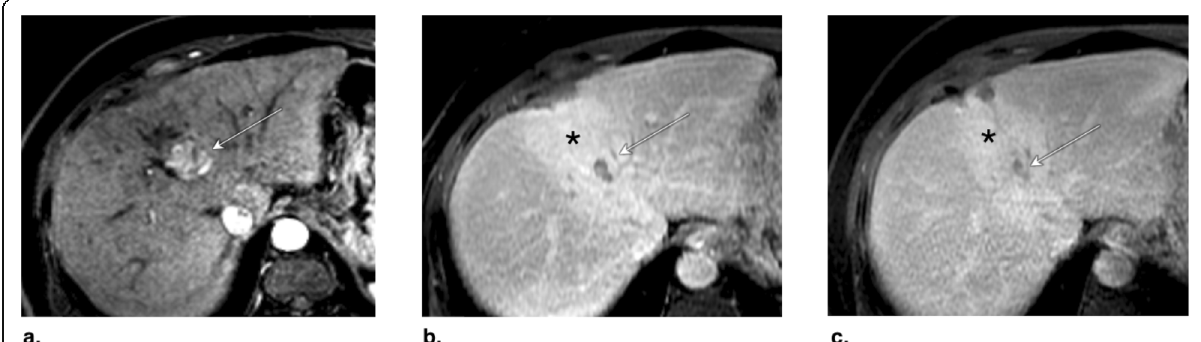
Fig. 29 Axial T1-weighted MR obtained ( a ) pretreatment: image in late arterial phase shows hyperenhancement of a 2.5 cm LR-5 observation. b 6 months post stereotactic body radiotherapy (SBRT): image in portal venous phase shows persistent 7-mm nodular enhancement (arrow), perfusional anomalies (asterisk), and capsular retraction. c 1 year post SBRT: image in portal venous phase shows absence of nodular enhancement and persistent but decreased perfusional anomalies. The treated observation is categorized LR-TR Nonviable